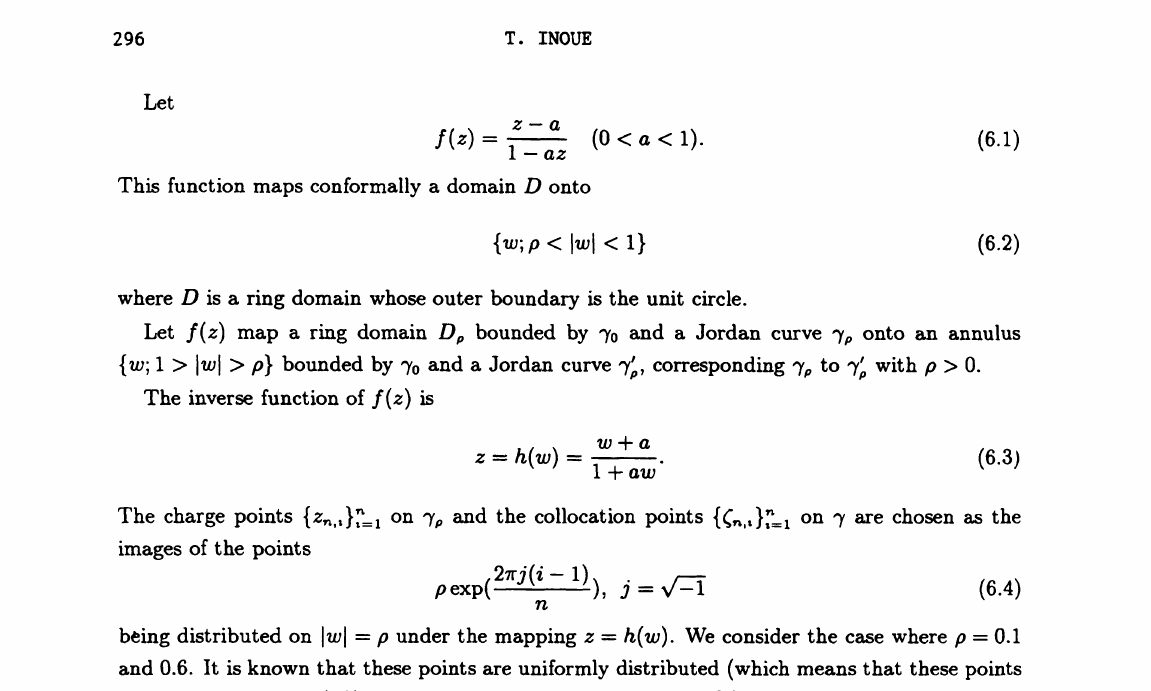
Table 1: Charges by Algorithm 4.4 for